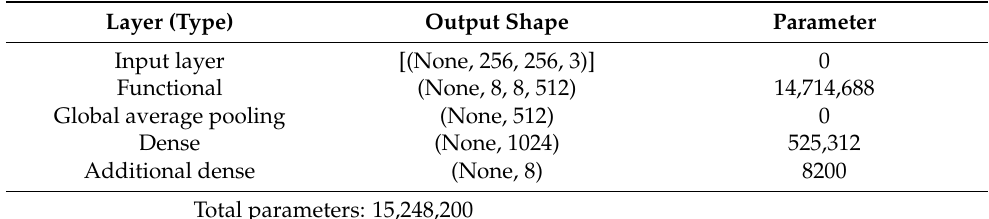
Figure 6. Evaluation phase losses for summer and winter season. Table 2. Layer information, reasoning speed summary.